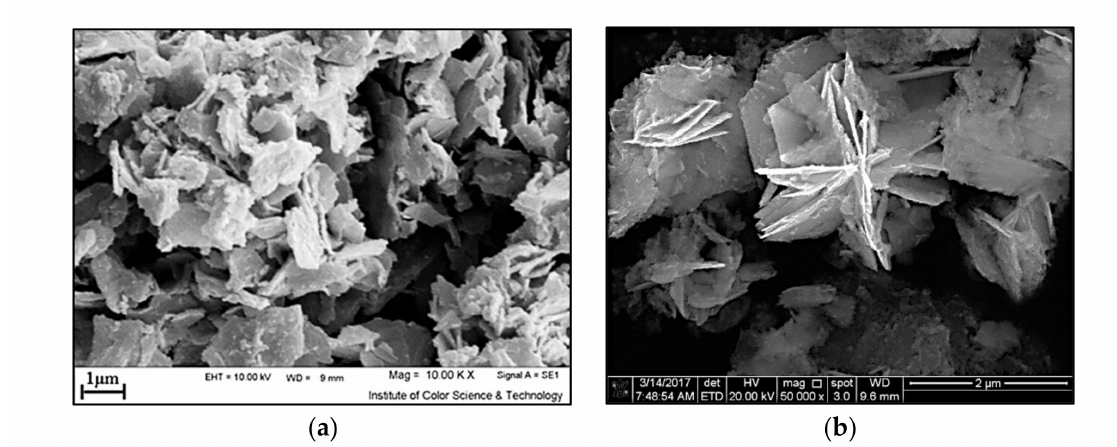
Figure 8. SEM images of ( a ) nanosheet Ce(MoO 4 ) 2 [80] and ( b ) g-C 3 N 4 / SnO photocatalyst [81].